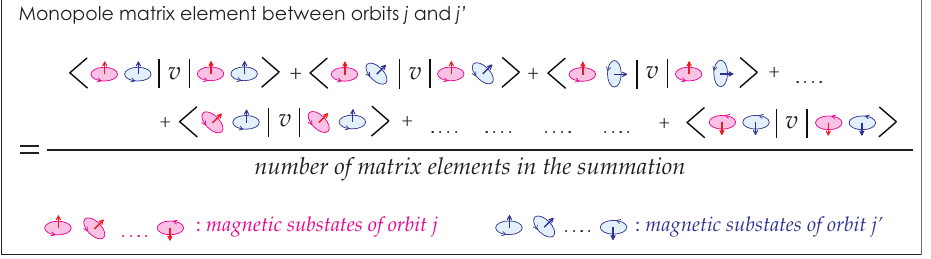
Figure 3. Schematic illustration of the monopole matrix element for a two-body interaction v . See text for details. Taken from Figure 7 of